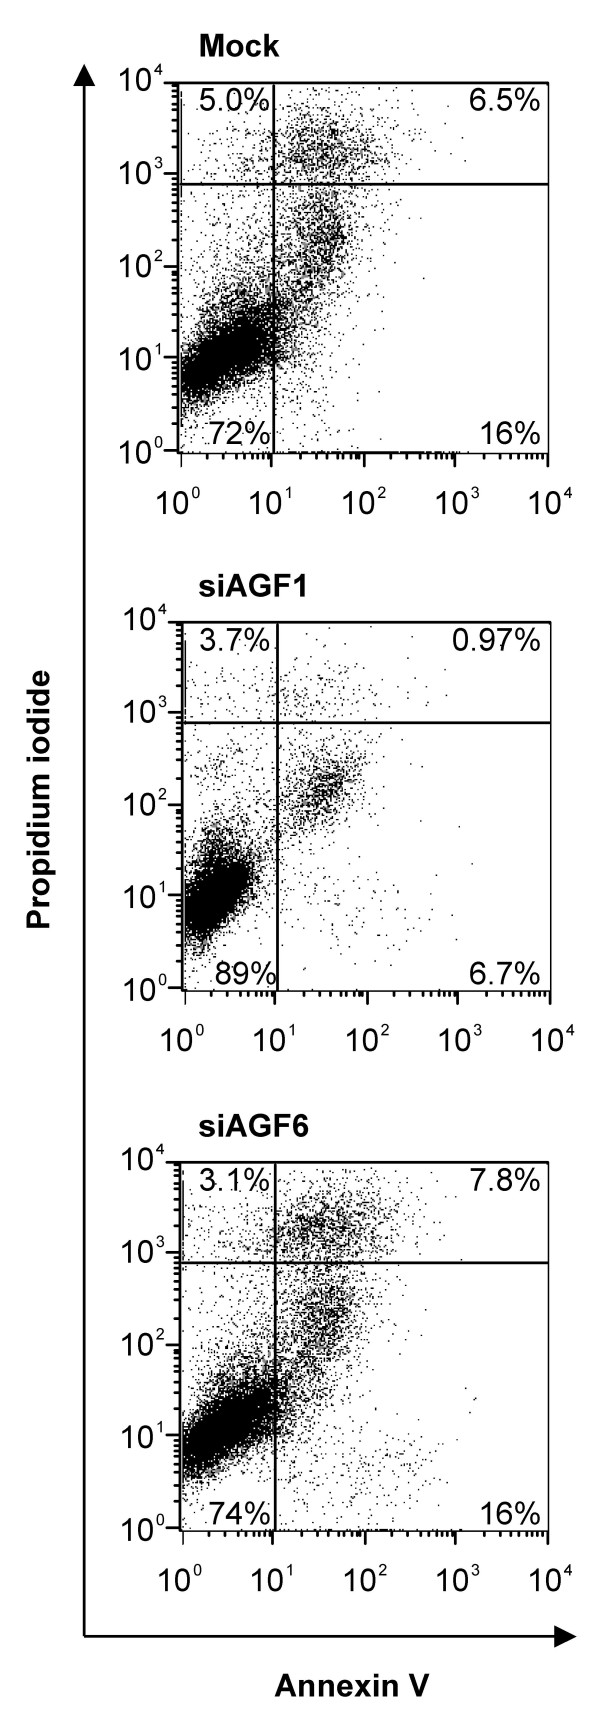
Effects of RUNX1-CBFA2T1 and RUNX1 suppression on extent of apoptosis in Kasumi-1 cells Kasumi-1 cells were electroporated at days 0 and 4, and were examined at day 8 by annexin V and propidium iodide staining followed by FACS analysis. One of two experiments yielding very similar results is shown. The percentage of cells is given for each quadrant of the plots.